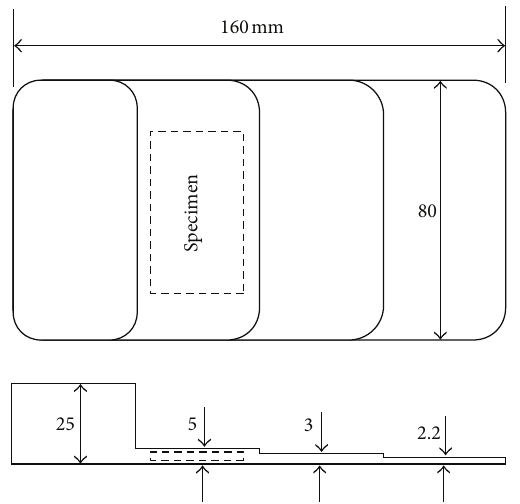
Figure 1: Sand mold and clipping position of specimens.